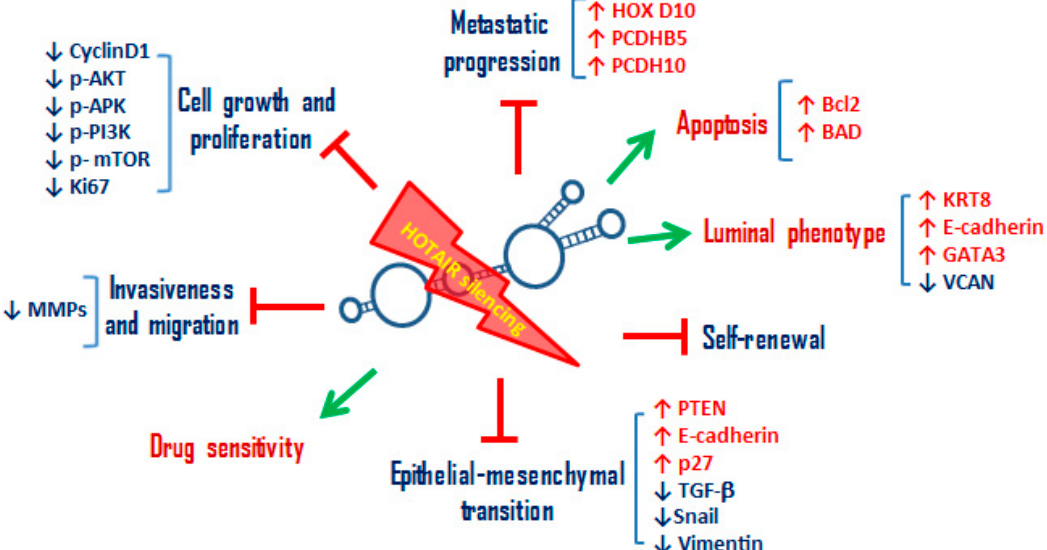
Figure 2. Schematic representation of the main cellular processes inhibited or activated by the silencing of HOTAIR in BC cells. HOTAIR knockdown in BC cells leads to the promotion of: (i) sensitivity to radiotherapy, chemotherapy, hormonal therapies and anti-HER2 therapies; (ii) luminal phenotype acquisition with the upregulation of luminal cytokeratins (KRT8), of cell adhesion molecule E-cadherin, and of transcription factor GATA3, responsible of luminal epithelial di ff erentiation in the adult mammary gland. Furthermore, HOTAIR silencing in BC cells leads to the inhibition of: (i) cell growth and proliferation by downregulating the main signaling pathways involved in these cellular processes, such as PI3K / AKT / mTOR and MAPK / ERK pathway, cyclin D1 and proliferation index Ki67; (ii) invasion and migration by downregulation of metalloproteinases; (iii) EMT by upregulating epithelial markers, such as E-cadherin , downregulating mesenchymal markers, such as Vimentin , and TGF-beta signaling; (iv) self-renewal, reducing colonosphere and mammosphere formation; (v) metastatic progression by upregulating metastasis suppressor genes, such as HOXD10, PCDHB5 , and PCDH10 . The green arrow indicates the activated processes, the symbol † the inhibited ones. KRT8: Keratin 8, GATA3: GATA Binding Protein 3, mTOR: mammalian target of rapamycin, MAPK: mitogen-activated protein kinase, ERK: Extracellular regulated kinases, PCDHB5: Protocadherin Beta 5, PCDH10: Protocadherin 10.